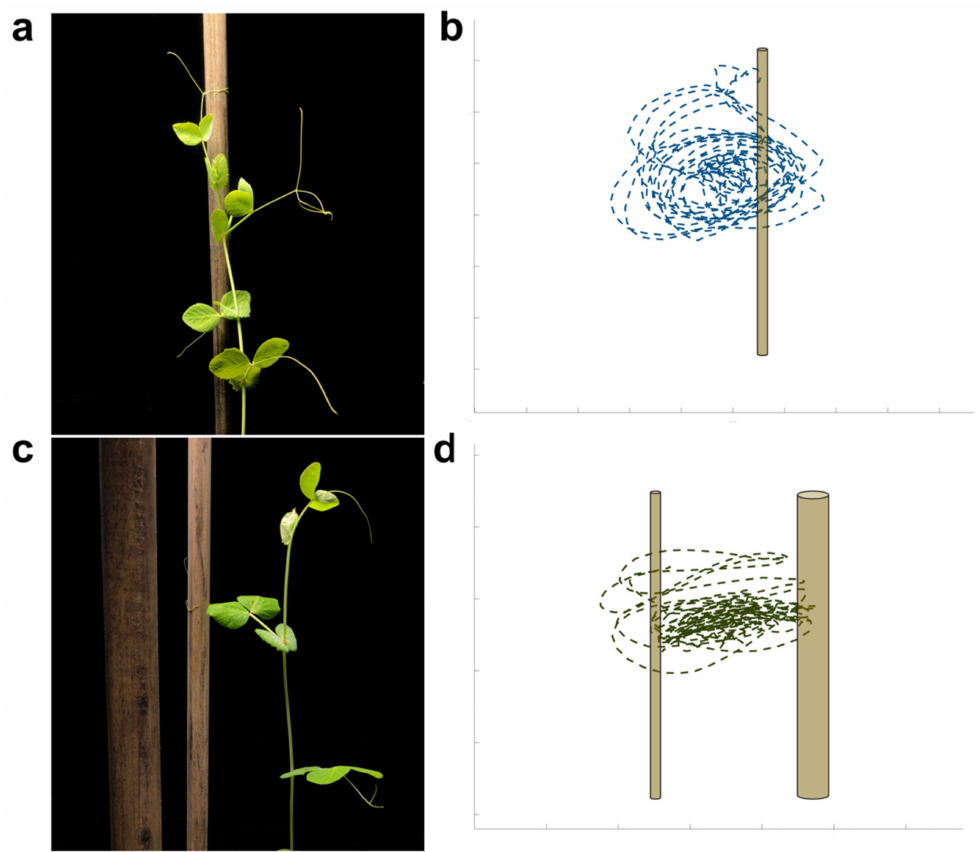
Figure 1. A frame representing an exemplar plant approaching the support for ( a ) the single-support (SS) condition with ( b ) a graphical representation of its trajectory. A plant approaching the